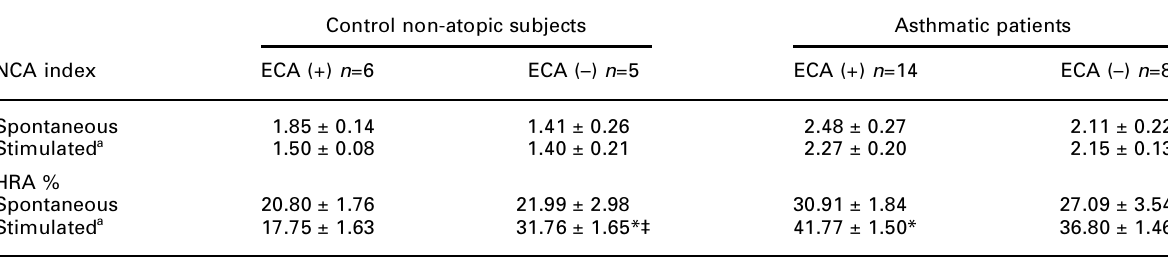
Table 1. Generation of NCA and HRA by mononuclear cells from control non-atopic subjects and from asthmatic patients sensitive to Der p I antigen; * P < 0.05 compared with non-stimulated cells; ‡ P < 0.05 compared with ECA (+) subgroup